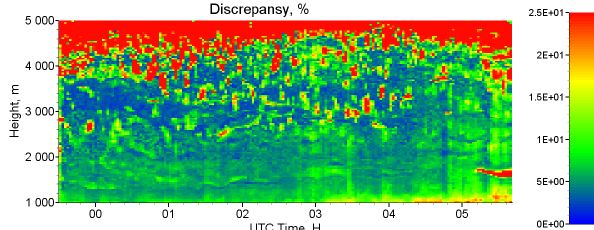
Figure 17. Discrepancy for the measurements on 27–28 August.